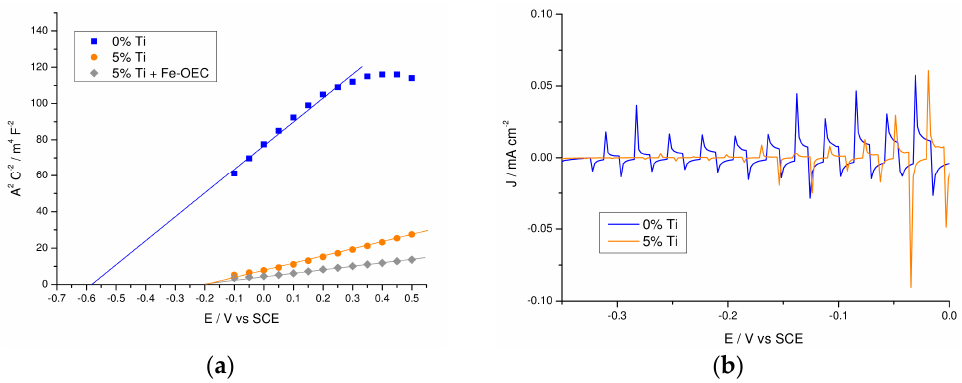
Figure 11. Mott-Schottky plot and photocurrent transients taken in the photocurrent onset potential region. ( a ) Mott-Schottky plot of un-modified and 5% Ti-modified sample before and after functionalization with Fe-OEC recorded at 100 Hz under AM 1.5 G illumination in NaOH 0.1 M (pH 13.3). Fitting lines are reported. ( b ) Magnification of the J–V curves recorded under shuttered illumination of un-modified and 5%-Ti modified hematite electrodes.